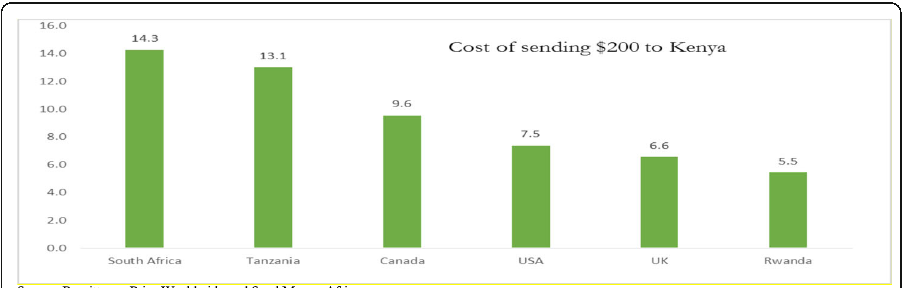
Fig. 5 Cost of sending money to Kenya by corridor in 2017. Source: Remittance Price Worldwide and Send Money